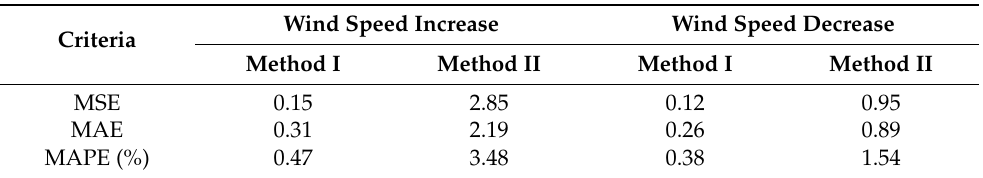
Figure 9. Residual results of Method I and II in normal working state within wind conditions: ( a ) wind speed increase; ( b ) wind speed decrease. Table 6. Statistical indicators of Method I and II in normal working state during wind speed increase and decrease.